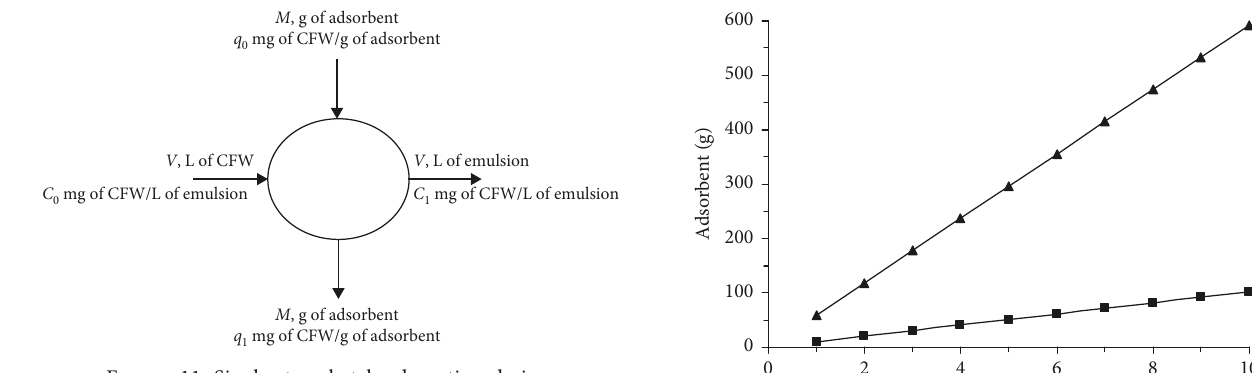
Figure 11: Single-stage batch adsorption design.